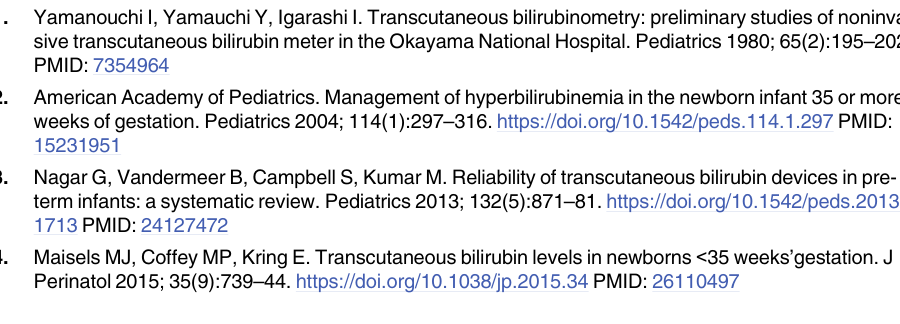
S1 Table. Contains the items of the Standards for Reporting of Diagnostic Accuracy (STARD) checklist, enabling to reporting studies of diagnostic accuracy according to a standard method. S1 Fig. Contains a receiver operating characteristic (ROC) curve with overall data of four methods to define TcB cut-off